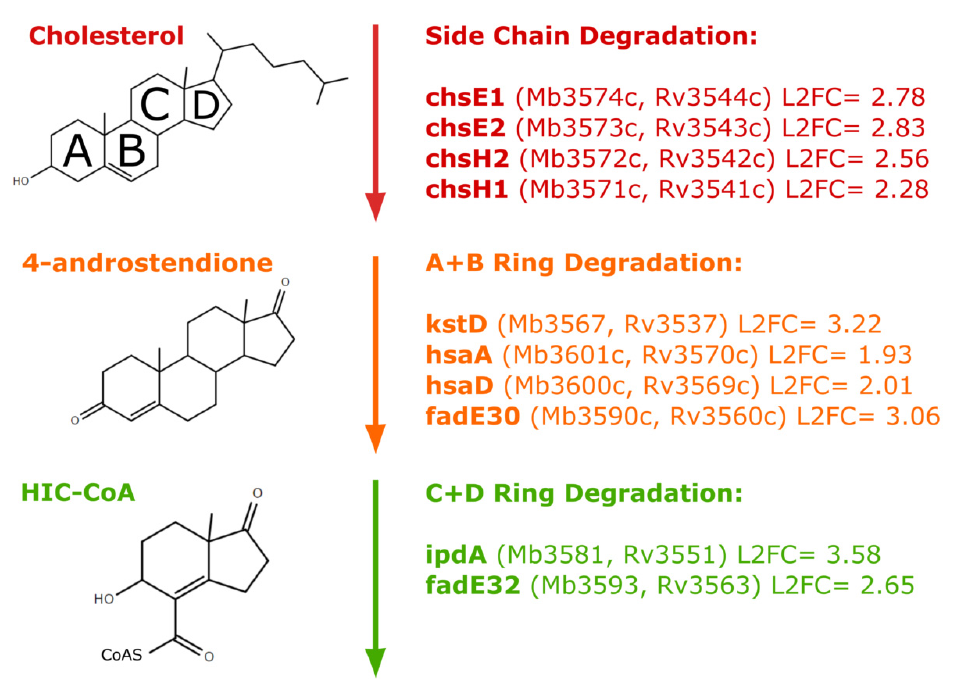
Figure 3 . Cholesterol degradation pathway genes upregulated after macrophage infection. M. bovis BCG genes significantly induced intracellularly are marked on the cholesterol degradation pathway [27]. Gene name and log2 fold change (L2FC) values are detailed alongside M. bovis AF2122/97 and M. tuberculosis H37Rv identifiers.